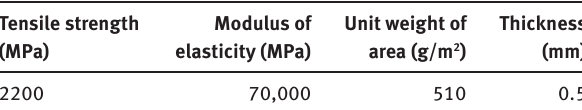
Table 5: Some physical and mechanical properties of glass fiber reinforced polymer